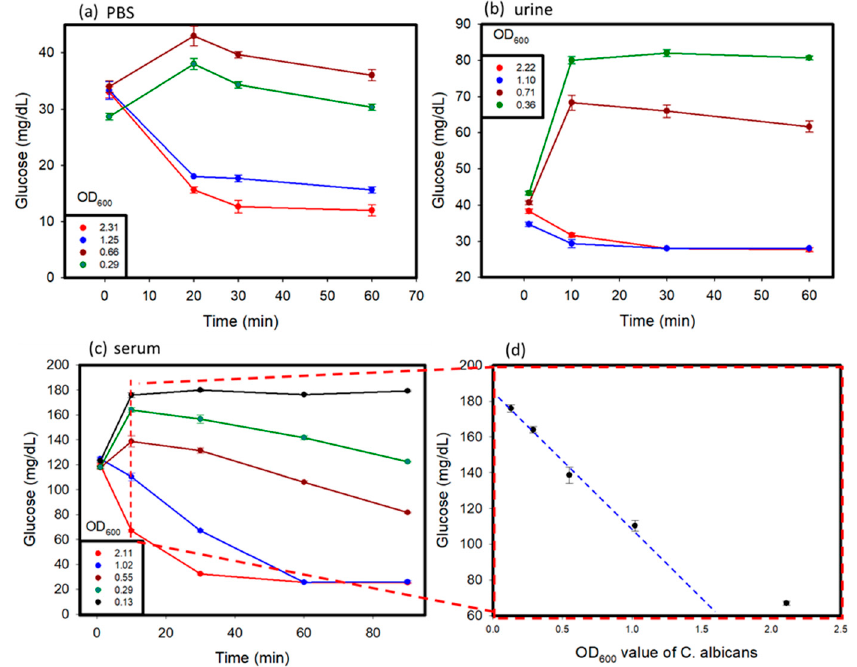
Figure 4. Spike sample test : C. albicans was suspended in ( a ) PBS, ( b ) urine, ( c ) serum solution, and ( d ) serially diluted samples to prepare spiked samples with varying concentrations. The OD 600 values of the samples were measured before testing.